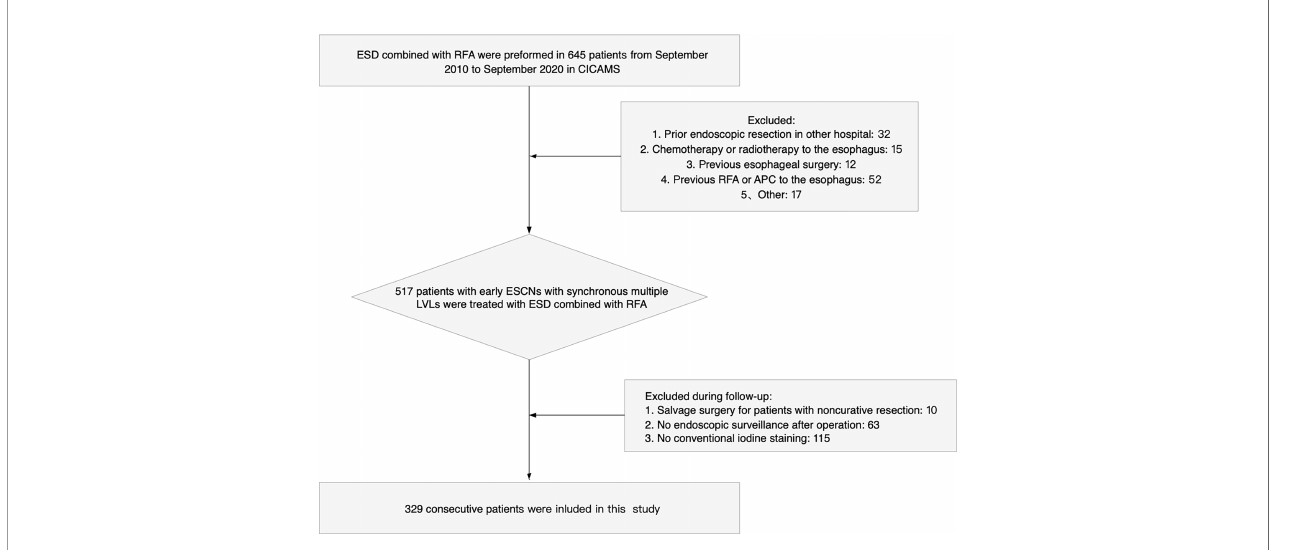
FIGURE 1 | Flowchart depicting patient selection and follow-up in the